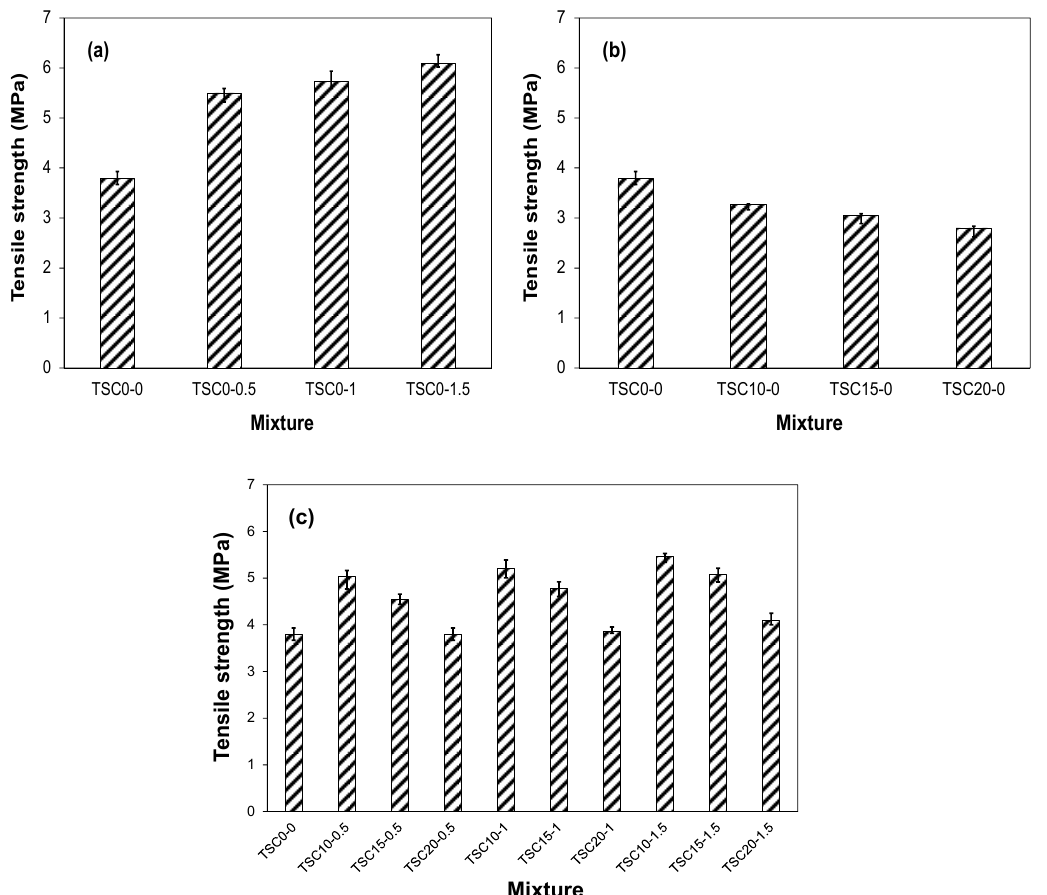
Figure 7. Tensile strength of different TSC specimens: ( a ) steel wires, ( b ) tire rubber, and ( c ) steel wire and tire rubber.